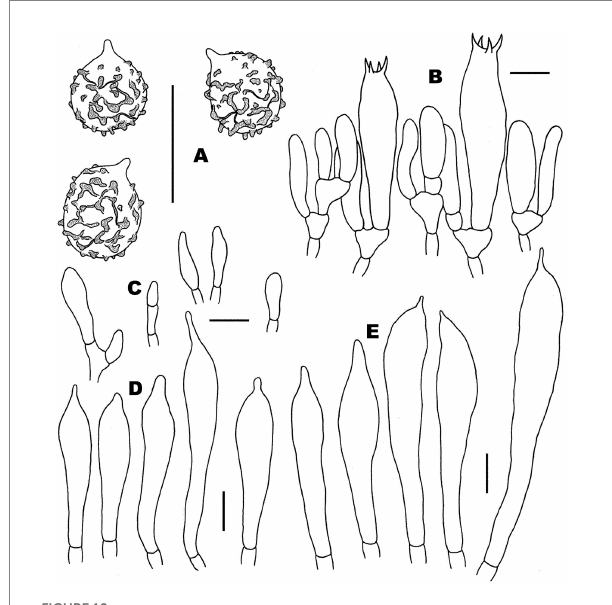
FIGURE 10 Microscopic features of Russula xanthovirens (FHMU1986). (A) Basidiospores. (B) Basidia and basidiola. (C) Marginal cells. (D) Pleurocystidia. (E) Cheilocystidia. Scale bars = 10 μ m. Drawings by Y. X.